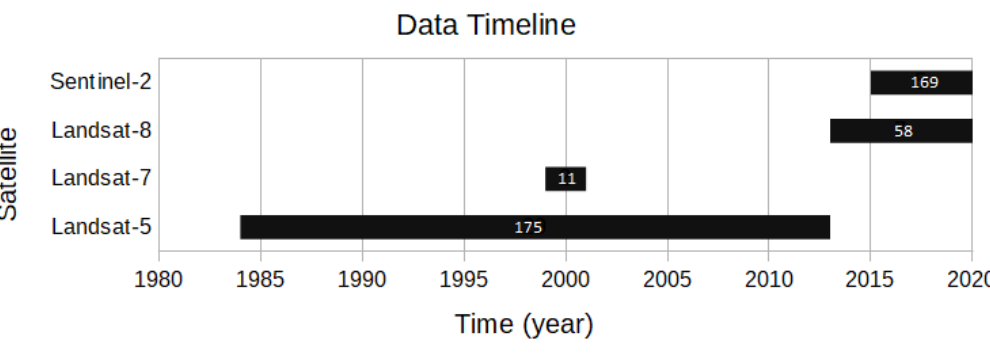
Figure 2. Temporal coverage of satellite imagery dataset used for timelapses of the Authie Bay and stability chronicles of the river. White labels refer to the number of selected images.